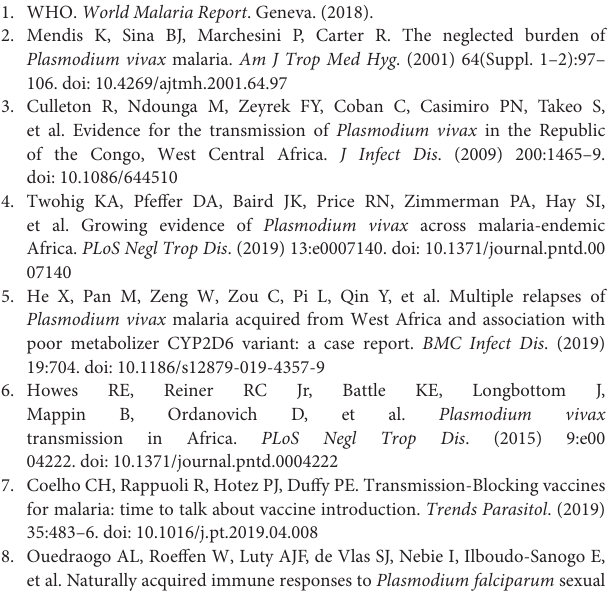
Table S1 | Background data for all subjects from Brazil and Cambodia. Information on sex, age, hemoglobin levels, and parasitemia. Parasitemia data in Brazil, originally reported in semi-quantitative format, were converted to parasites per mm3 to be compared with data from Cambodia, reported as parasites/mm3.